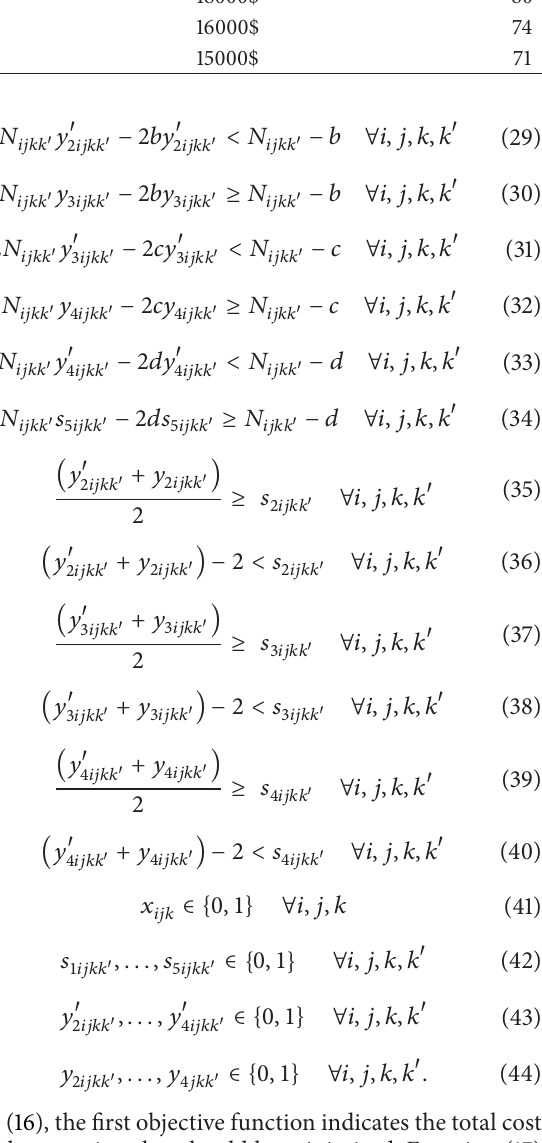
each part are limited to a minimum value. Equation (22) ensures that at least one dimension is implemented in each part. Equations (26)–(44) indicate the linearization of 𝑤 𝑖𝑗𝑘𝑘 󸀠